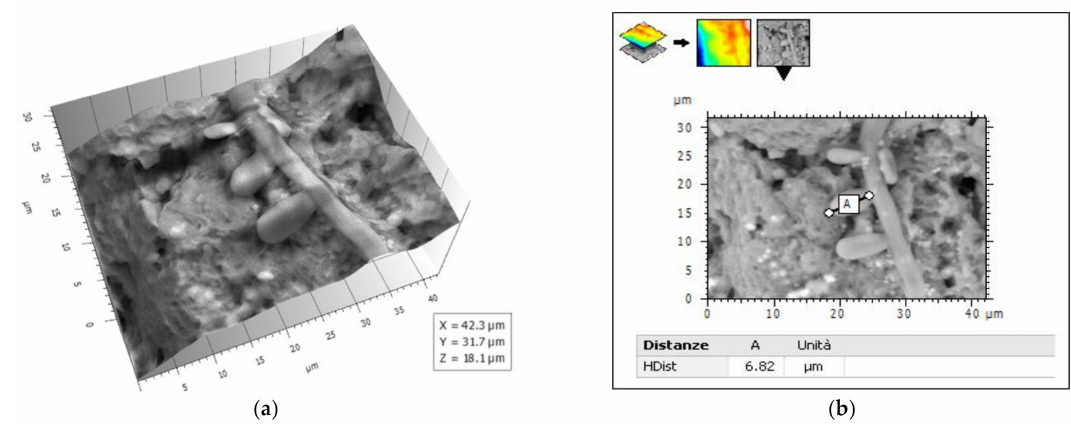
Figure 10. ( a ) 3-D reconstruction from picture in Figure 9 by 3D Hitachi Mountains 7 software. ( b ) Conidium length